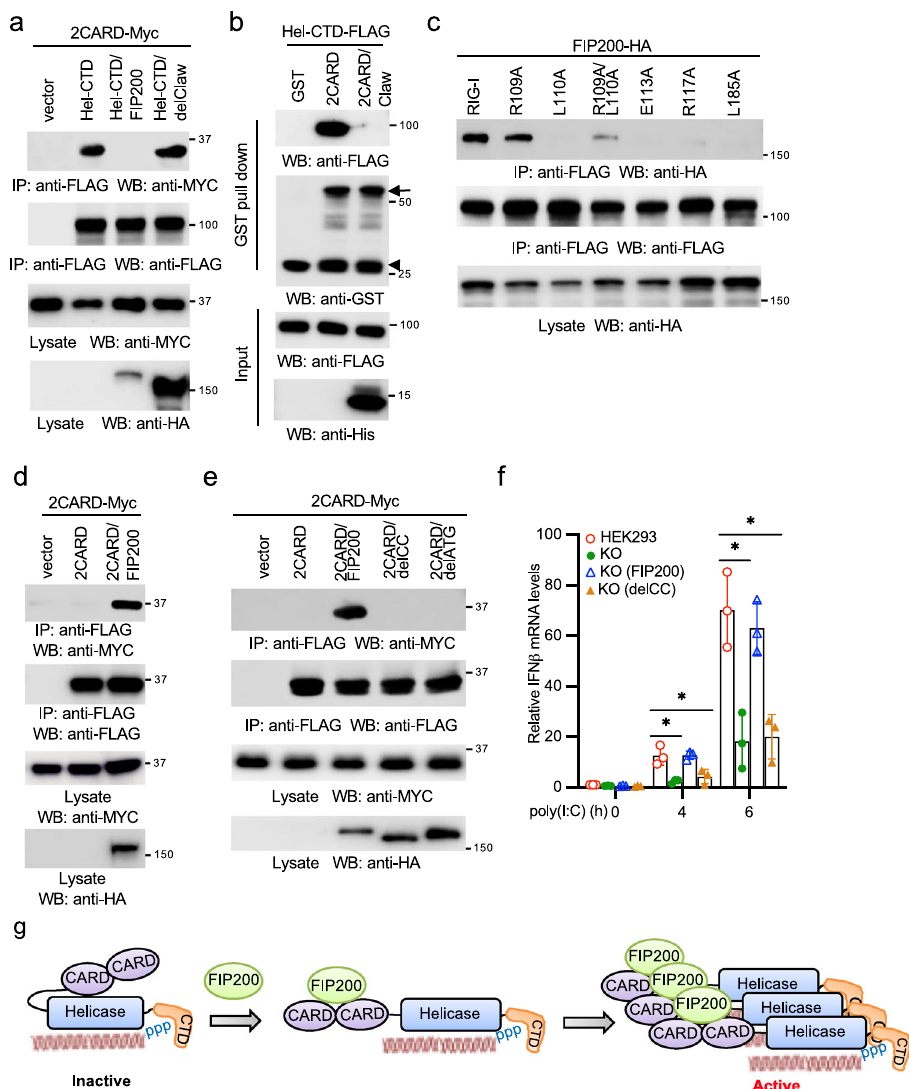
Fig. 8 FIP200 facilitates the release and oligomerization of 2CARD. a Myc-tagged 2CARD (2CARD-Myc) was co-transfected with vector, the FLAG- tagged Hel-CTD, Hel-CTD plus HA-tagged FIP200, or Hel-CTD plus HA-tagged delClaw into HEK293 cells. After 48 h, cell lysates were immunoprecipitated and blotted as indicated. b Puri fi ed recombinant FLAG-tagged Hel-CTD (Hel-CTD-FLAG) was mixed with GST, GST-tagged 2CARD (2CARD-GST) or 2CARD-GST plus His-tagged Claw at 4 °C. After 16 h, GST pull-down assay was performed. Arrow indicates the 2CARD-GST. Arrowhead indicates the cleaved GST from 2CARD-GST during extraction and puri fi cation from E. coli . c FIP200-HA was co-transfected with wild-type RIG-I or the indicated point mutant into HEK293 cells. After 48 h, cell lysates were immunoprecipitated and blotted as indicated. d 2CARD-Myc was co-transfected with vector, FLAG-tagged 2CARD (2CARD-FLAG), 2CARD-FLAG plus FIP200-HA into HEK293 cells. After 48 h, cell lysates were immunoprecipitated and blotted as indicated. e 2CARD-Myc was co-transfected with vector, 2CARD-FLAG, 2CARD-FLAG plus FIP200-HA, delCC-HA or delATG-HA into HEK293 cells. After 48 h, cell lysates were immunoprecipitated and blotted as indicated. f Wild-type HEK293 cells, FIP200 knockout cells, FIP200 knockout cells reconstituted with full-length FIP200 or the delCC mutant were stimulated with 1 μ g ml − 1 poly(I:C) for designated times. RNA was extracted and real-time PCR for IFN β was performed. All experiments were biologically repeated three times. Data represent means ± s.d. of three independent experiments. The P - value was calculated (two-tailed Student ’ s t test) by comparison with HEK293 cells. * P < 0.05. g Model of FIP200-mediated RIG-I